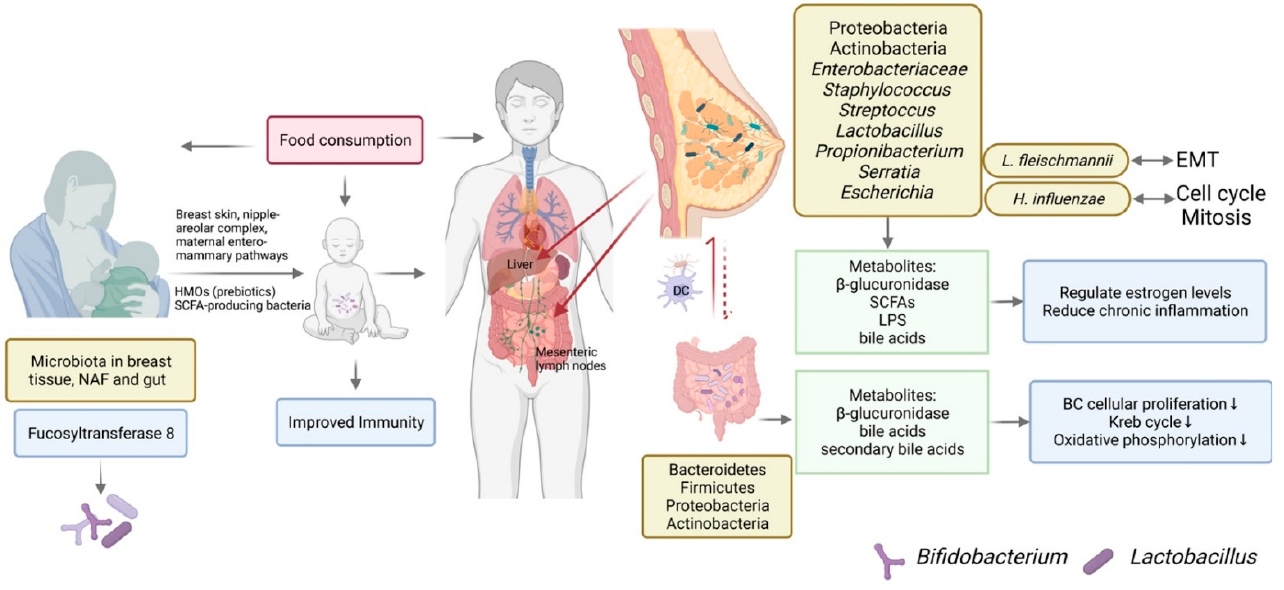
Figure 1. The origin and anti-cancer roles of breast microbiota and milk microbiota. NAF, nipple aspirate fluid; HMOs, human milk oligosaccharides; DC, dendritic cell; SCFAs, short-chain fatty acids; LPS, lipopolysaccharides; and EMT, epithelial–mesenchymal